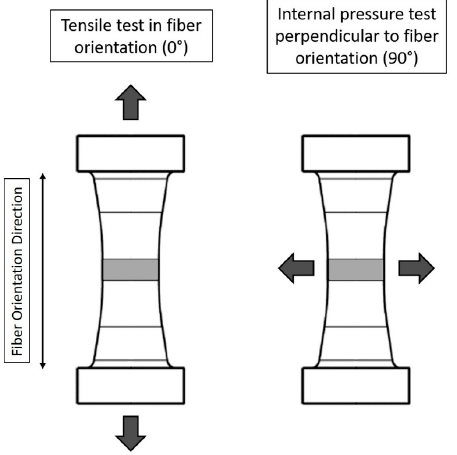
Figure 9. Representation of the performed tensile and internal pressure load cases in 0° and 90° fiber orientation of the tube specimen.